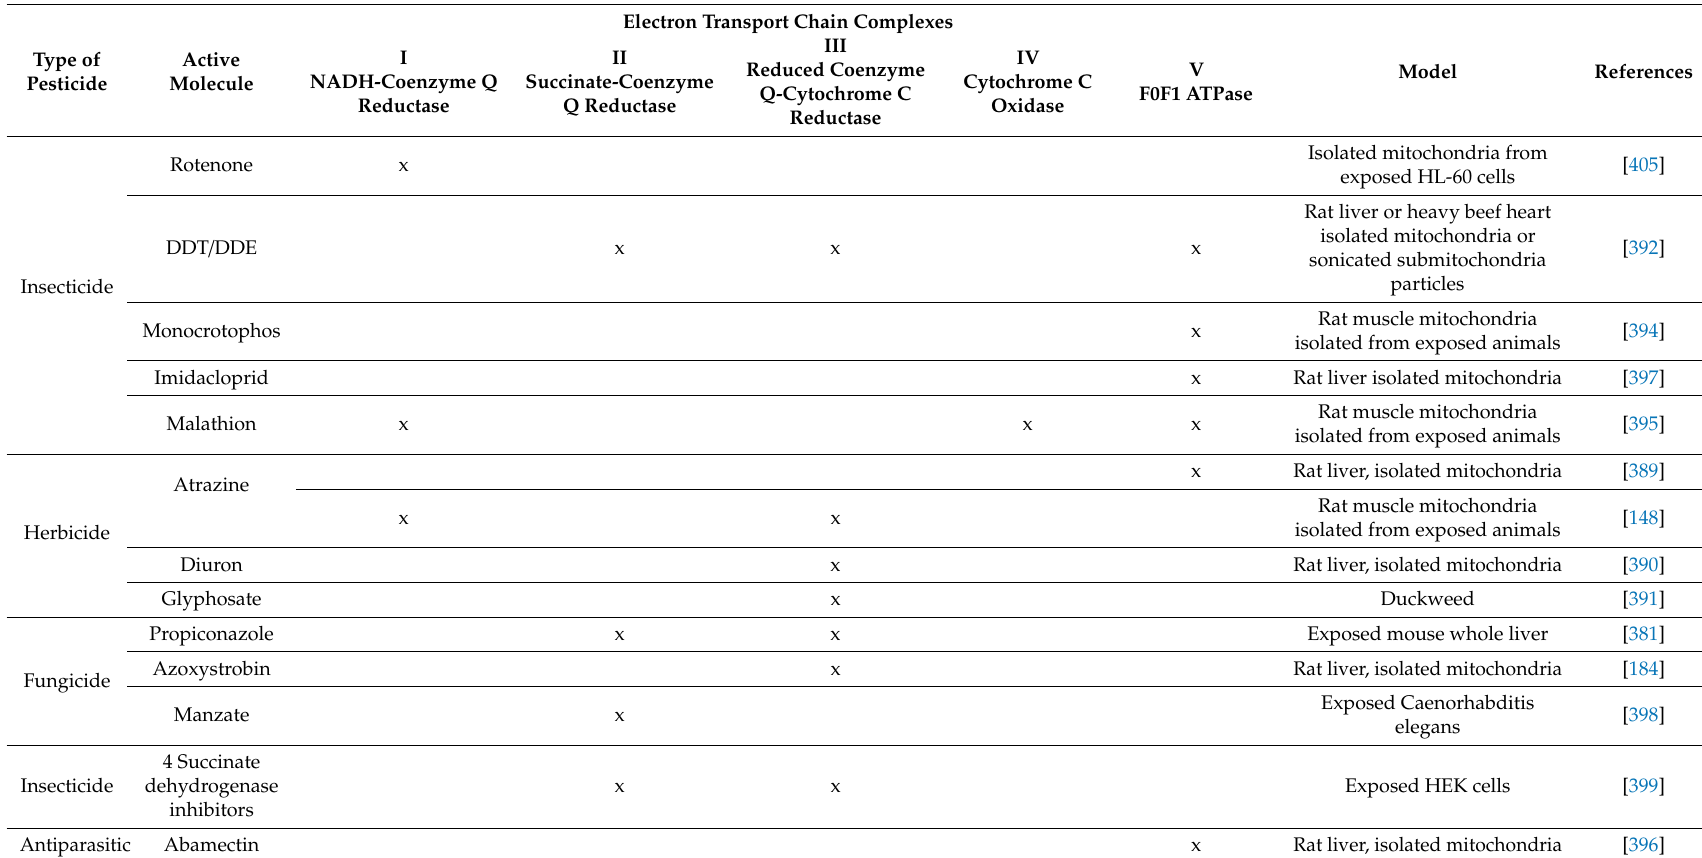
Table 4. Impact of pesticide on mitochondrial electron transport chain